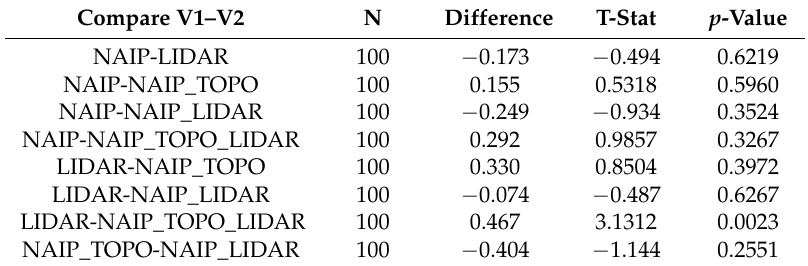
Table A3. QMD paired comparisons between models developed from combinations of NAIP, LiDAR, and Topo data sources.